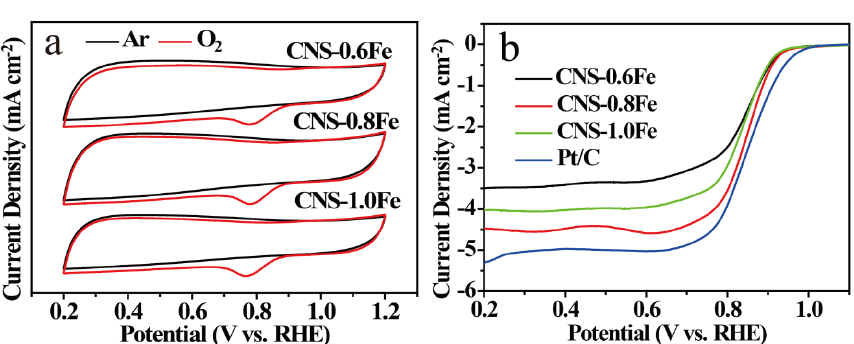
/ s. ( b ) 2 , scan rate: 50 V